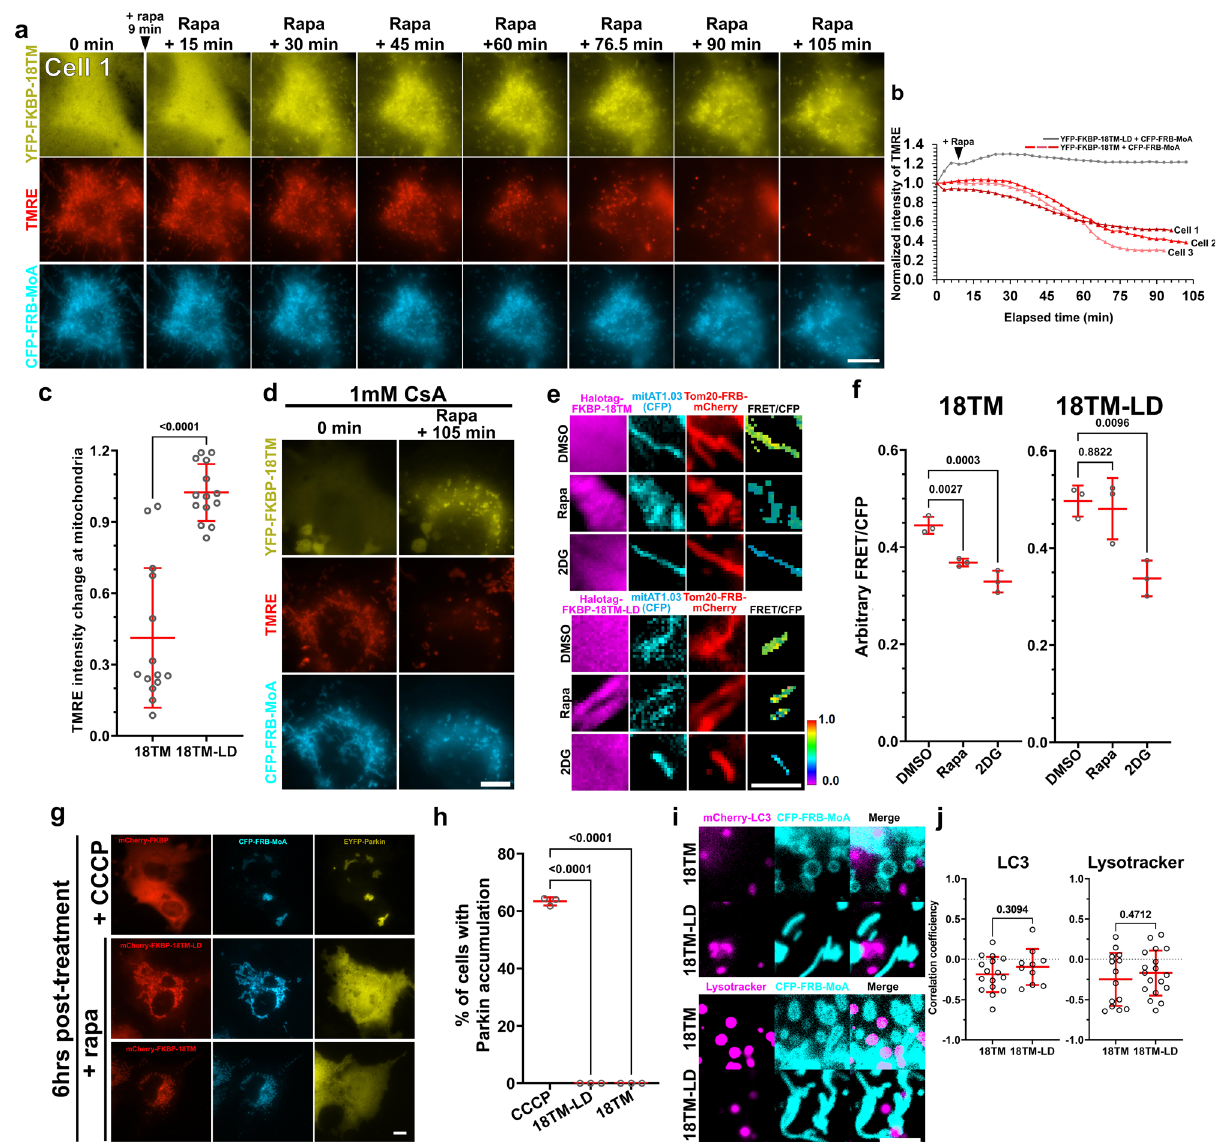
100nM rapamycin (middle), 25mM 2-DG (bottom) ( e ). Scale bar, 5 μ m. Arbitrary FRET/CFP ratio values were obtained from three independent experiments ( n = 3 biologicallyindependentcells)( f ). g FluorescenceimagesofCOS-7cellsexpressing YFP-ParkinandCFP-FRB-MoAalongwitheithermCherry-FKBP,-18TMor-18TM-LD. Cells were treated with 10 μ M CCCP or rapamycin for 6 h. h A fraction of cells indicatingco-localizationofYFP-Parkinandmitochondriawascalculated(manually counted). n =168, 294 and 241 cells from left to right; analyzed from three indivi- dualexperiments. i, j Basedonthe fl uorescence imagesof cells co-expressingCFP- FRB-MoA and either mCherry-FKBP-18TM or -18TM-LD, and either expressing mCherry-LC3 or stained with Lysotracker, which were treated with rapamycin for 6h( i ),theircolocalizationcoef fi cientsweremeasured( n =16,10,14,18fromleftto right,biologicallyindependentcellsfromthreeindependentexperiments)( j ).Error bars, means ± s.d. Statistical signi fi cance was determined by one-way ANOVA with Dunnett ’ s multiple comparison and p values are indicated on the graph. Scale